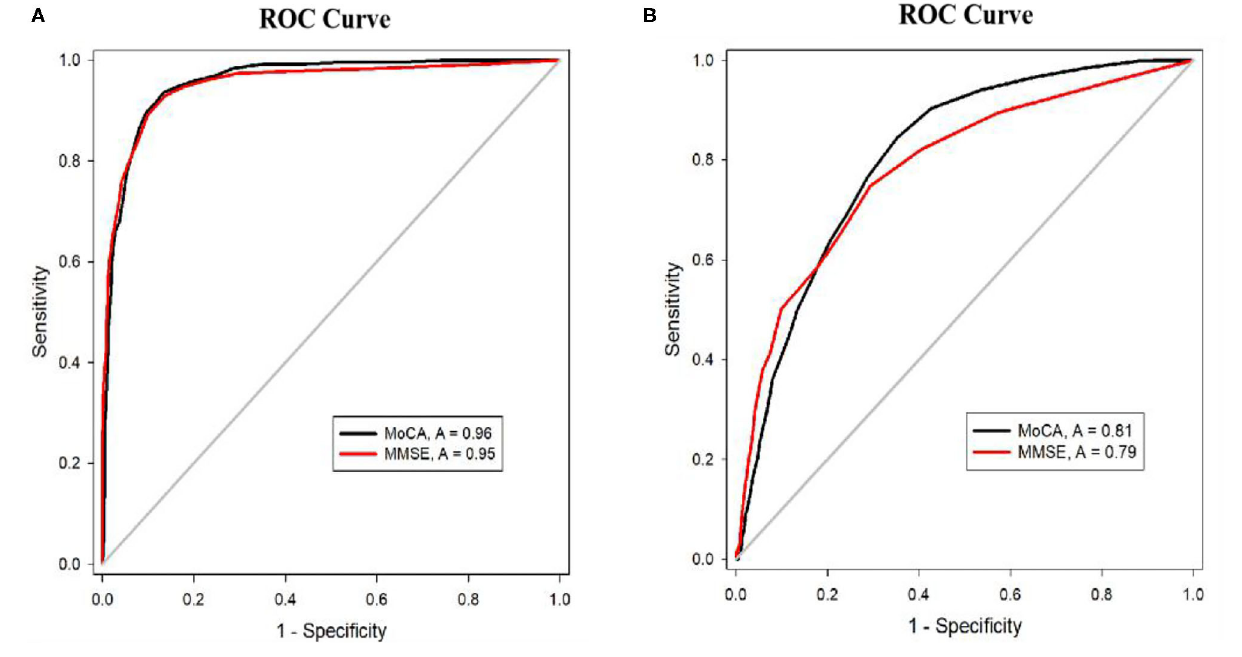
FIGURE 1 | (A) ROC curves for MoCA and MMSE for the detection of dementia. (B) ROC curves for MoCA and MMSE for the detection of